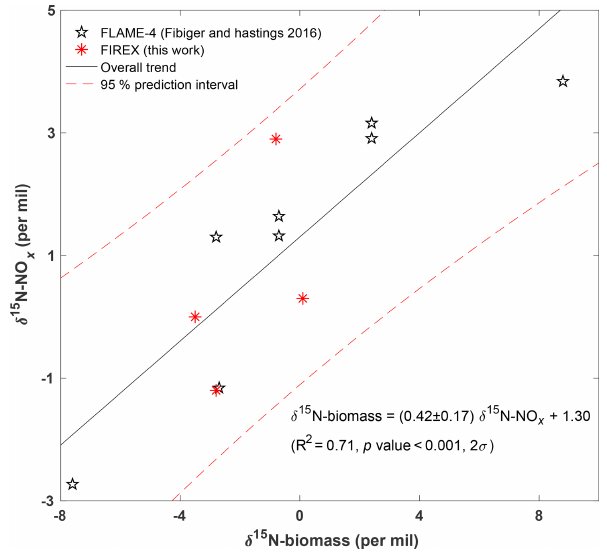
Figure 5. Dependence of δ 15 N–NO x on δ 15 N–biomass. Star data points represent results from the FLAME-4 study (Fibiger and Hast- ings, 2016); asterisk data points represent results from this work; the solid line is a linear regression between δ 15 N–NO x and δ 15 N– biomass for the combined dataset; dashed lines are 95% prediction intervals (2 σ ).